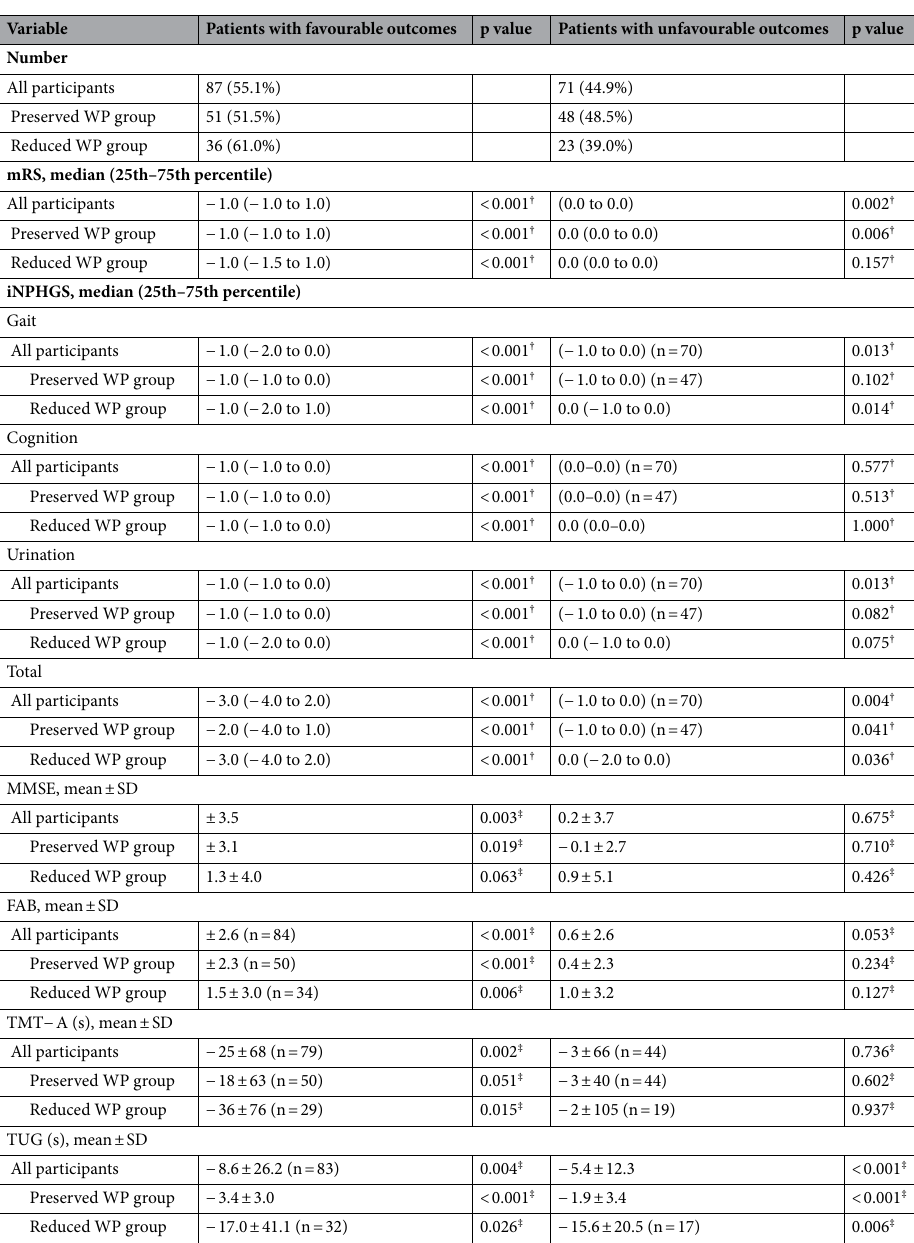
Table 3. Changes in clinical measures after shunt implantation. FAB Frontal Assessment Battery, iNPH idiopathic normal-pressure hydrocephalus, iNPHGS idiopathic Normal-Pressure Hydrocephalus Grading Scale, MMSE Mini-Mental State Examination, mRS modified Rankin Scale, TMT-A Trail Making Test A, TUG timed up-and-go test, WP walking performance. † The Wilcoxon signed-ranked test was used. ‡ The paired Student’s t-test was